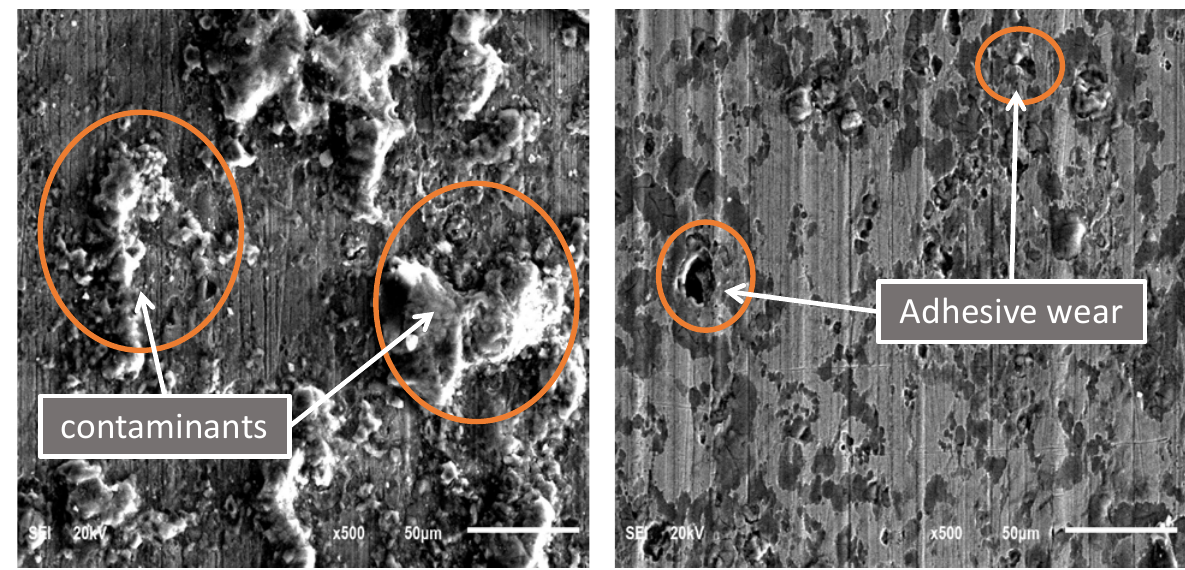
Figure 12. SEM images of the P110 worn casing sample (S4) tested under wet conditions (water-based drilling fluid) at 115 rpm and 1400 N.